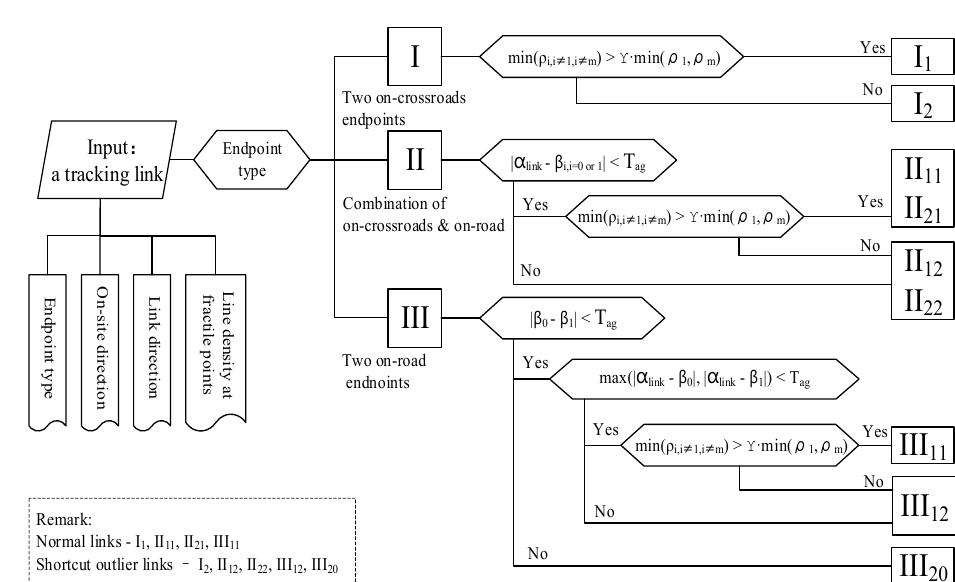
Figure 4. A schematic diagram showing the spatial reasoning workflow.